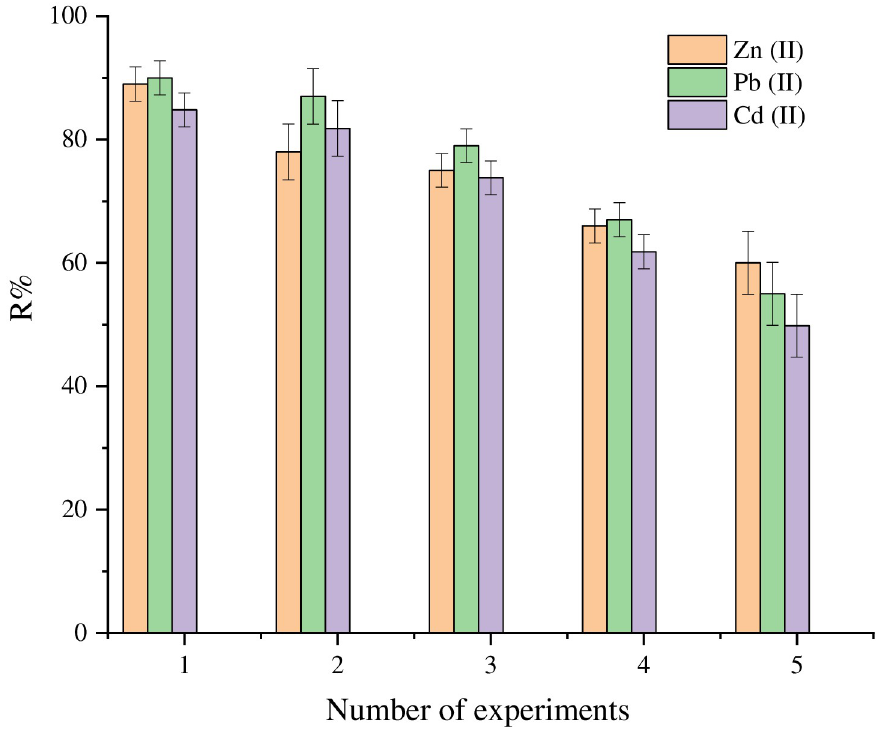
Fig 15. Desorption of Zn +2 , Pb +2 , and Cd +2 and regeneration process of SnCaAl 2 O 3